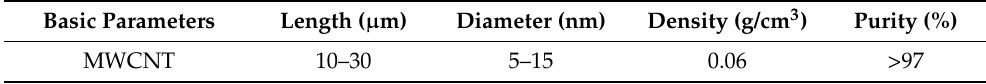
Table 1. Basic parameters of multi-walled carbon nanotubes. Basic